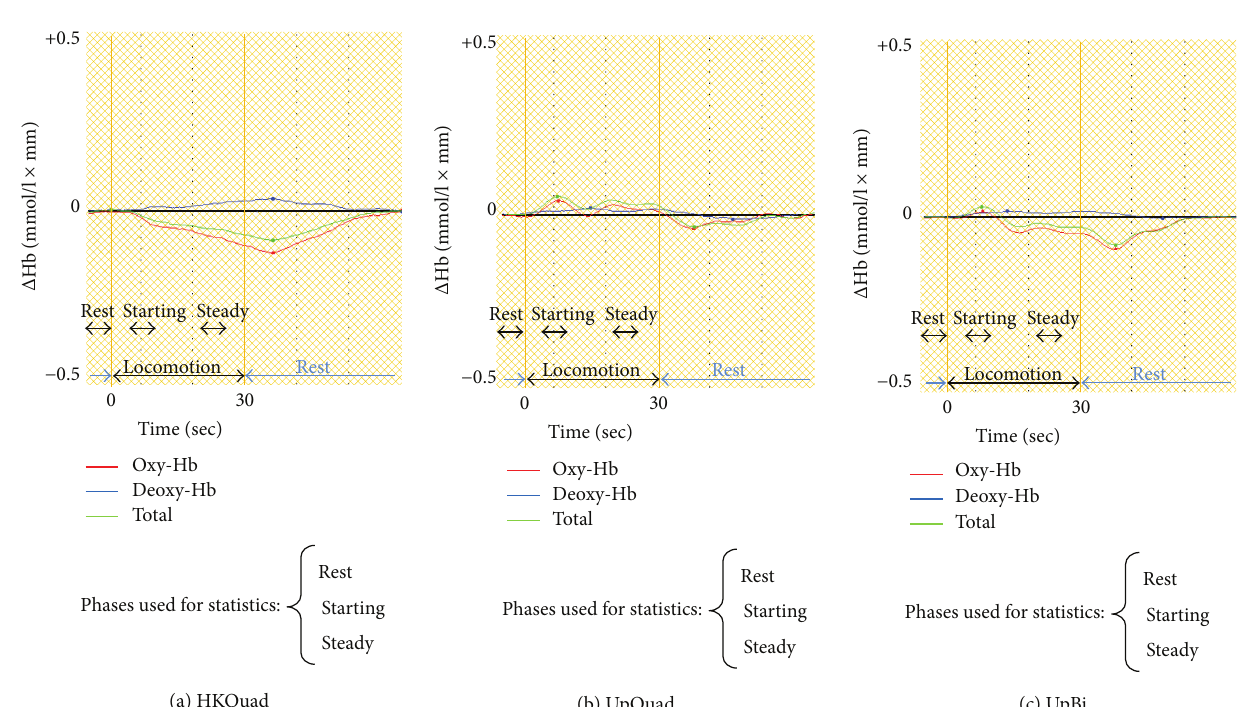
Figure5:Grandmeanoxy-Hbconcentrationwaveformsacrossallparticipants.(a)Hand-kneequadrupedalcrawling(HKQuad).(b)Upright quadrupedalism (UpQuad) using bilateral Lofstrand crutches. (c) Usual upright bipedalism (UpBi). Waveforms in red, blue, and green represent the concentrations of oxy-Hb, deoxy-Hb, and total Hb, respectively.